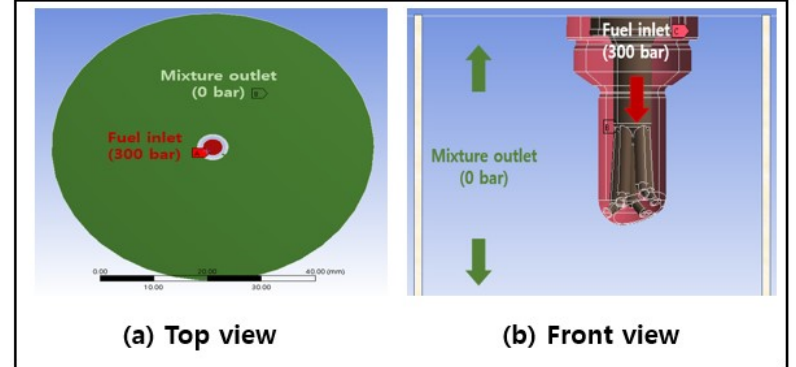
Figure 3. Boundary condition for injection simulation.